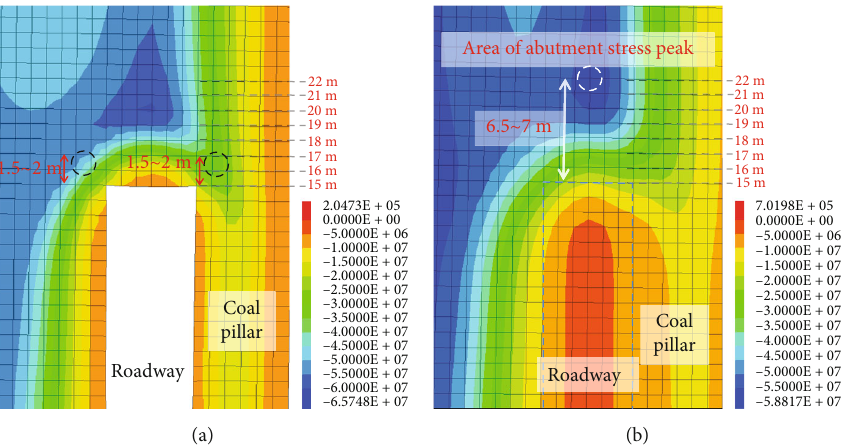
Figure 8: The vertical stress distribution law of coal and rock mass in the unmined area in front of excavation working face: (a) roof rock area and (b) two ribs of the roadway coal